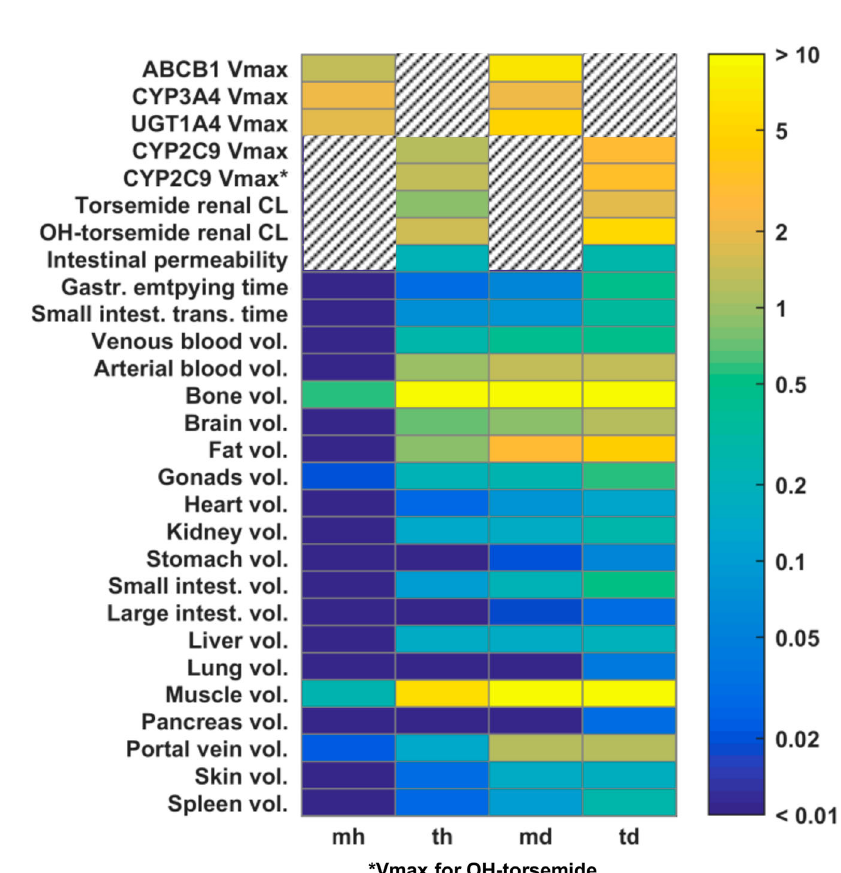
Fig. 5 Learning progression. Heat map shows Kullback – Leibler divergence (relative entropy) between acquired knowledge and initial knowledge for each learning step. Color code represents learning progression from blue (learned nothing) to yellow (learned very much). Hatching indicates that parameters have not been considered in the respective model such that relative entropy could not be